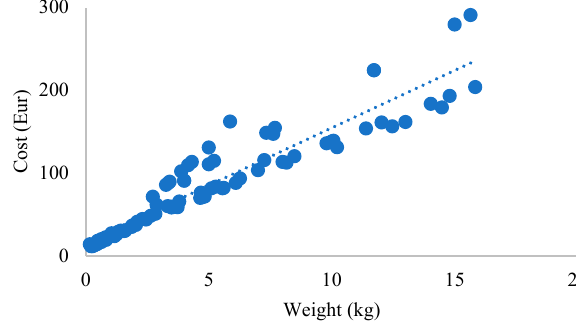
Figure 17. The fitting of the heatsink cost.